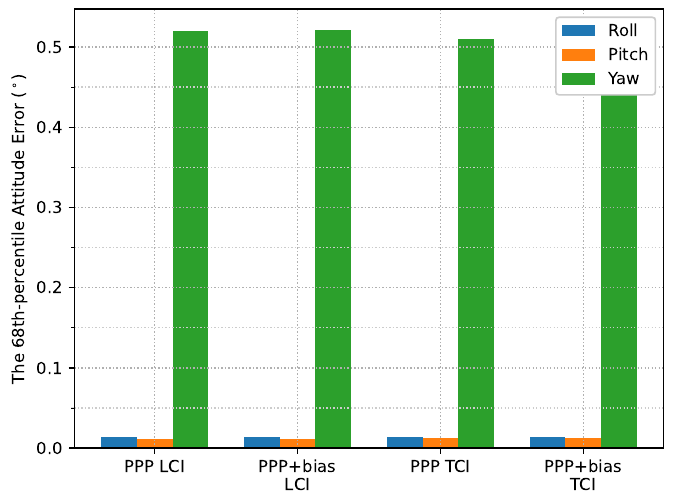
Figure 34. Attitude error RMS of real-time GPS/Galileo PPP/INS positioning of city center test on 27 January 2022 with respect to IE RTK/INS TCI